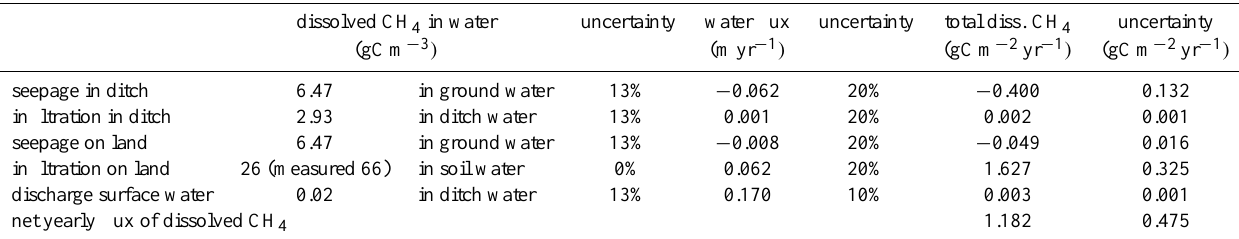
Table 9. Results of the water analyses for dissolved CH 4 in the water, water fluxes over the year and total fluxes of dissolved CH 4 transported by water.